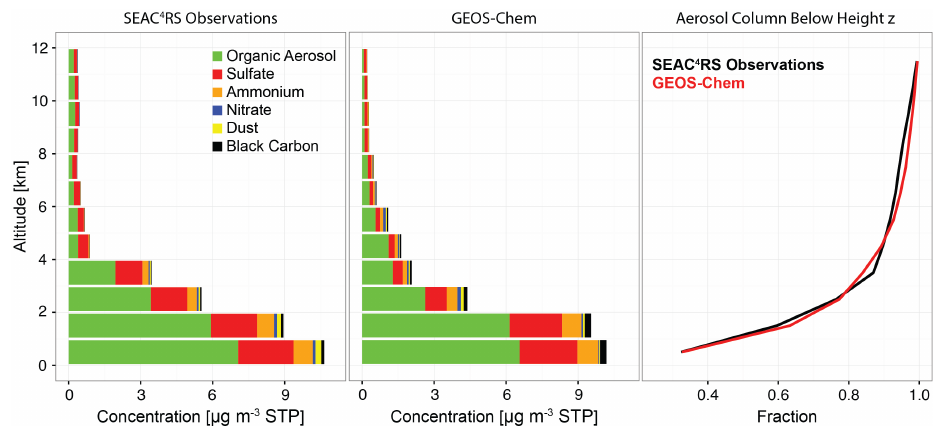
Figure 6. Median vertical profiles of aerosol composition over the southeast US during SEAC 4 RS (August–September 2013). Observations from the DC-8 aircraft (left) are compared to GEOS-Chem values sampled at the aircraft times and locations (center). Also shown is the observed and simulated fraction of the total aerosol mass column below a given height (right). The southeast US domain is as defined in Fig.